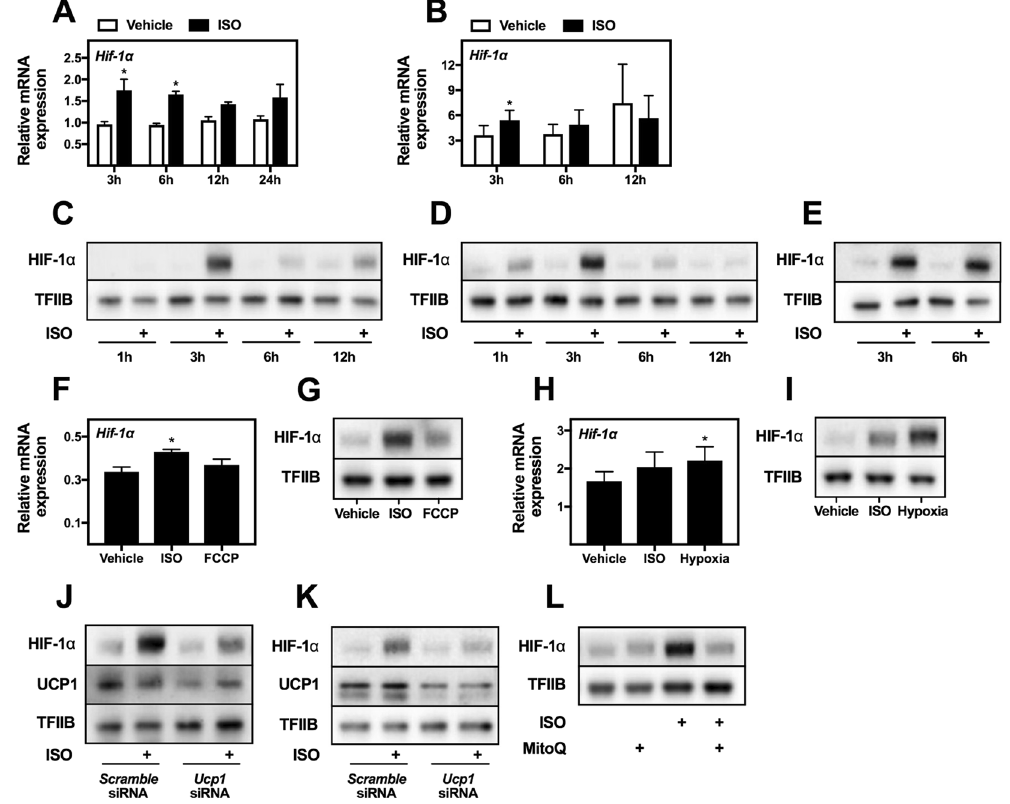
Figure 4. Hif-1 α mRNA and HIF-1 α protein levels. ( A ) Total RNA was isolated from mature brown adipocytes (WT-1). Relative mRNA expression was measured by RT-qPCR for Hif-1 α in cells treated with vehicle (white bars) or 0.1 μ M ISO (black bars) for 3, 6, 12 or 24 h (n = 4). ( B ) Total RNA was isolated from primary mature brown adipocytes. Relative mRNA expression was measured by RT-qPCR for Hif-1 α in cells treated with vehicle (white bars) or 0.1 μ M ISO (black bars) for 3, 6 or 12 h (n = 4). Immunoblotting analysis of HIF-1 α in ( C ) WT-1 brown adipocytes and in ( D ) primary brown adipocytes stimulated with vehicle or ISO for 1, 3, 6 and 12 h. ( E ) Immunoblotting analysis of HIF-1 α in human brown adipocytes stimulated with vehicle or ISO for 3 or 6 h. ( F ) Relative gene expression for Hif-1 α (n = 4) and ( G ) immunoblotting analyses of HIF-1 α were performed on mature brown adipocytes (WT-1) treated with vehicle, 0.1 μ M ISO or 1 μ M FCCP for 12 h (gene expression) or 4 h (immunoblotting). ( H ) Relative gene expression for Hif-1 α (n = 4) and ( I ) immunoblotting analysis of HIF-1 α were performed on mature brown adipocytes (WT-1) treated with vehicle, 0.1 μ M ISO or exposed to hypoxia (1% O 2 ) for 12 h (gene expression) or 3 h (immunoblotting). ( J ) Immunoblotting analysis for HIF-1 α and UCP1 was performed on mature brown adipocytes (WT-1) or ( K ) in mature primary brown adipocytes, which were reverse transfected with a scramble siRNA or siRNAs against Hif-1 α at day 6 after initiation of differentiation or 8 days after isolation, respectively. Four days later, the adipocytes were stimulated with vehicle or 0.1 μ M ISO for 3 h. mRNA levels were normalized to Tbp . ( L ) Immunoblotting analysis for HIF-1 α was performed on mature brown adipocytes (WT-1), which were pretreated or not with 5 μ M MitoQ for 1 h, followed by stimulation with vehicle or 0.1 μ M ISO for an additional 3 h. Data represent mean of means + SEM. * p < 0.05 versus vehicle (panel A, B, F and H). TFIIB was used as loading control for immunoblotting (panel C–E, G and I–L). Full-length blots for panels C–E, G and I–L are shown in Supplementary Figure